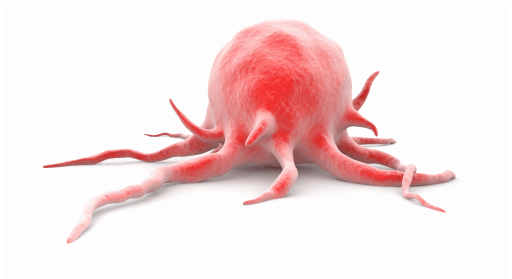
Figure 1. Tridimensional tumor’s geometrical model [7]. Bidimensional projections of this model will be considered for the study